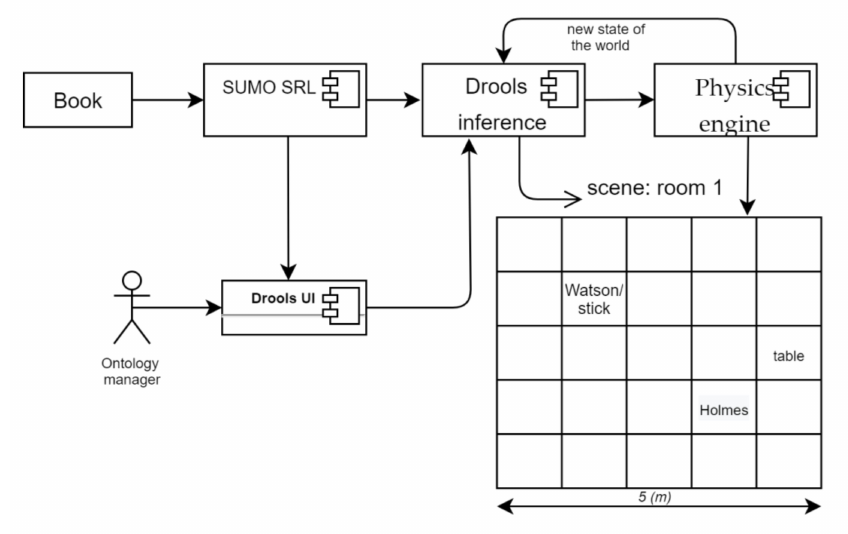
Figure 2. Text-to-3D physics engine. The conceptual model of the proposed